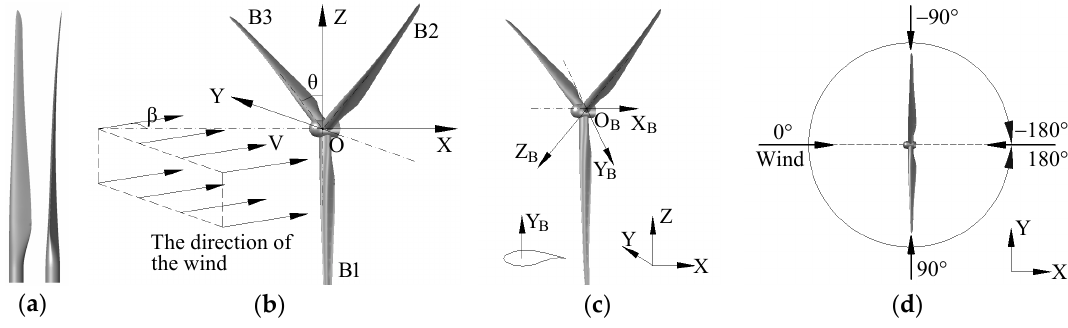
Figure 1. Geometric model of the wind turbine rotor: ( a ) The geometry of the blade; ( b ) The rotor coordinate system; ( c ) The blade coordinate system; ( d ) Direction changes of the violent wind.